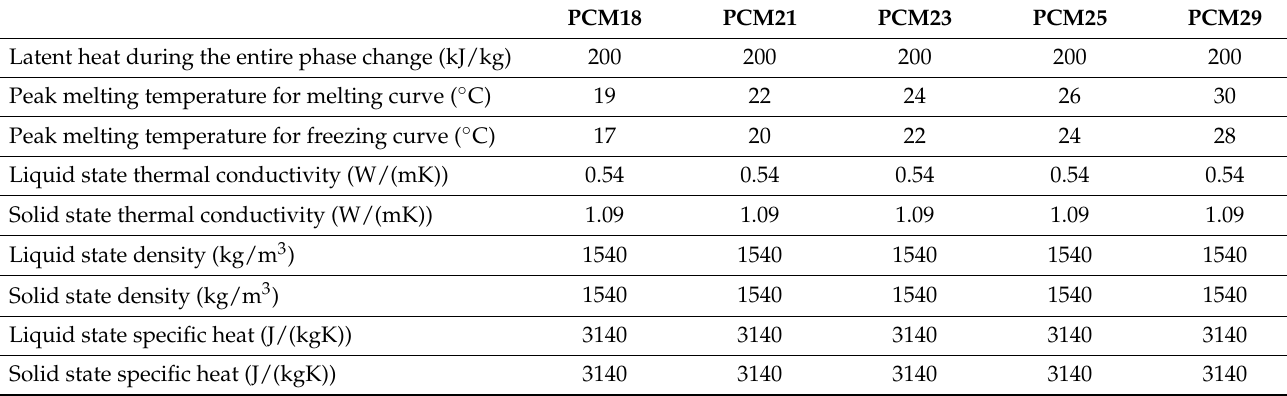
Table 2. Thermophysical properties of